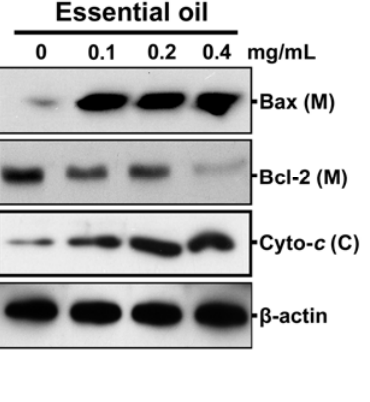
Figure 6. Involvement of mitochondrial stress in the essential oil-mediated apoptosis of KB cells. The cells were treated with the indicated doses of the essential oil for 12 h. Cell lysates were analyzed by 12% sodium dodecyl sulfate-polyacrylamide gel electrophoresis followed by immunoblot analysis. A representative result from three independent experiments is shown. M and C represent the mitochondria and cytosolic fractions,